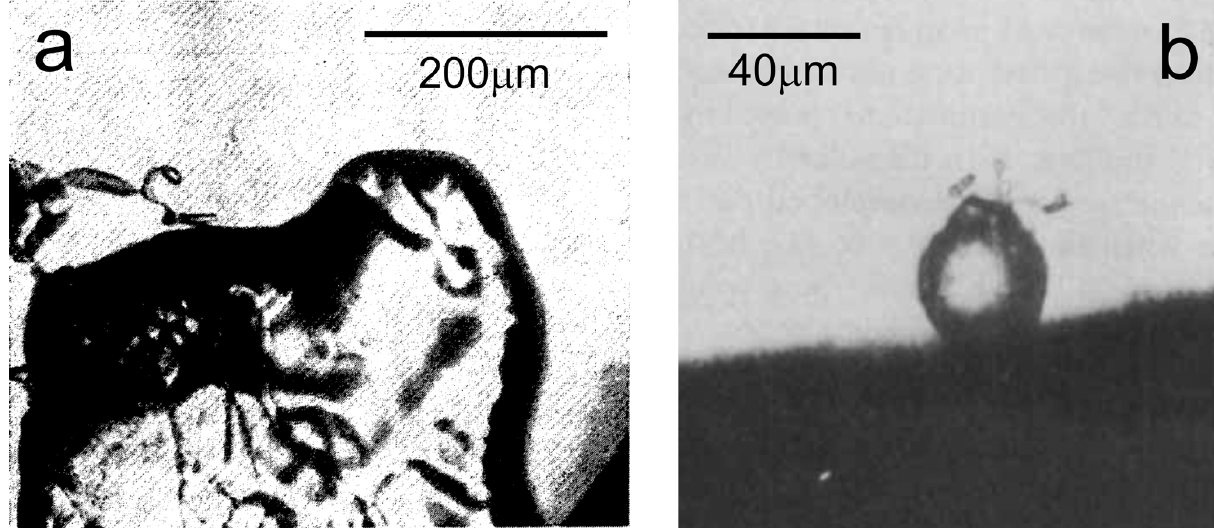
Figure 12. Pictures of the rime fragments: (a) frozen splash observed at T a = − 6 ◦ C and a speed of 6ms − 1 (Macklin, 1960); (b) disruptions of protuberances formed out of a 35µm rimed droplet at T a = − 7 ◦ C and speed 1.5ms − 1 (Choularton et al.,